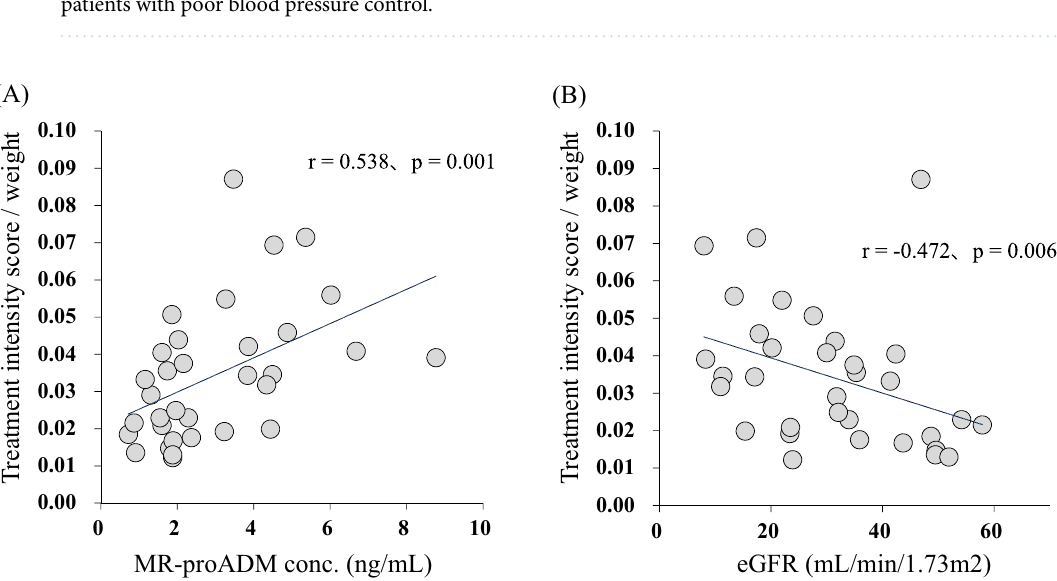
Figure 2. Correlation between treatment intensity score and (A) mid-regional pro-adrenomedullin (MR-proADM) concentration, (B) estimated glomerular filtration rate (eGFR) in chronic kidney disease patients with poor blood pressure control.